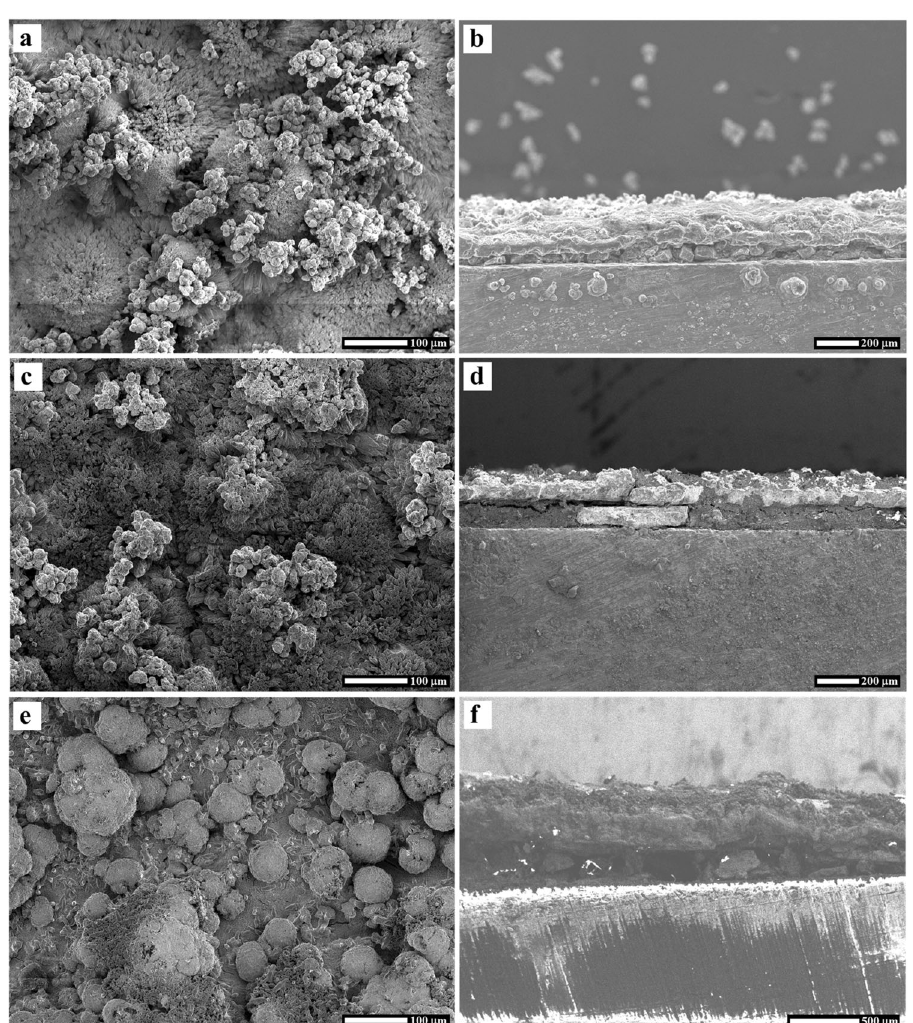
Fig. 11 SEM. Scanning electron microscopy images of the surfaces and cross-sections of electrodes at 40 days of experiment: a , b 3-1#, c , d 9-1#, and e , f 14-1#, respectively.